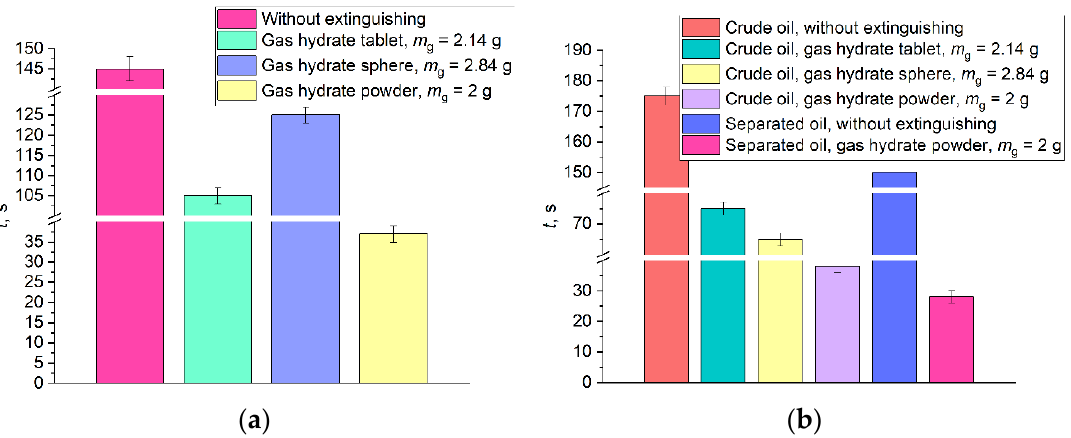
Figure 6. Extinction times of ( a ) diesel fuel ( V 0 ≈ 3 mL) and ( b ) petroleum ( V 0 ≈ 3 mL) pool fires without extinguishing and when suppressed by CO 2 hydrate in the form of powder, tablets, and spheres with varying initial mass m g .